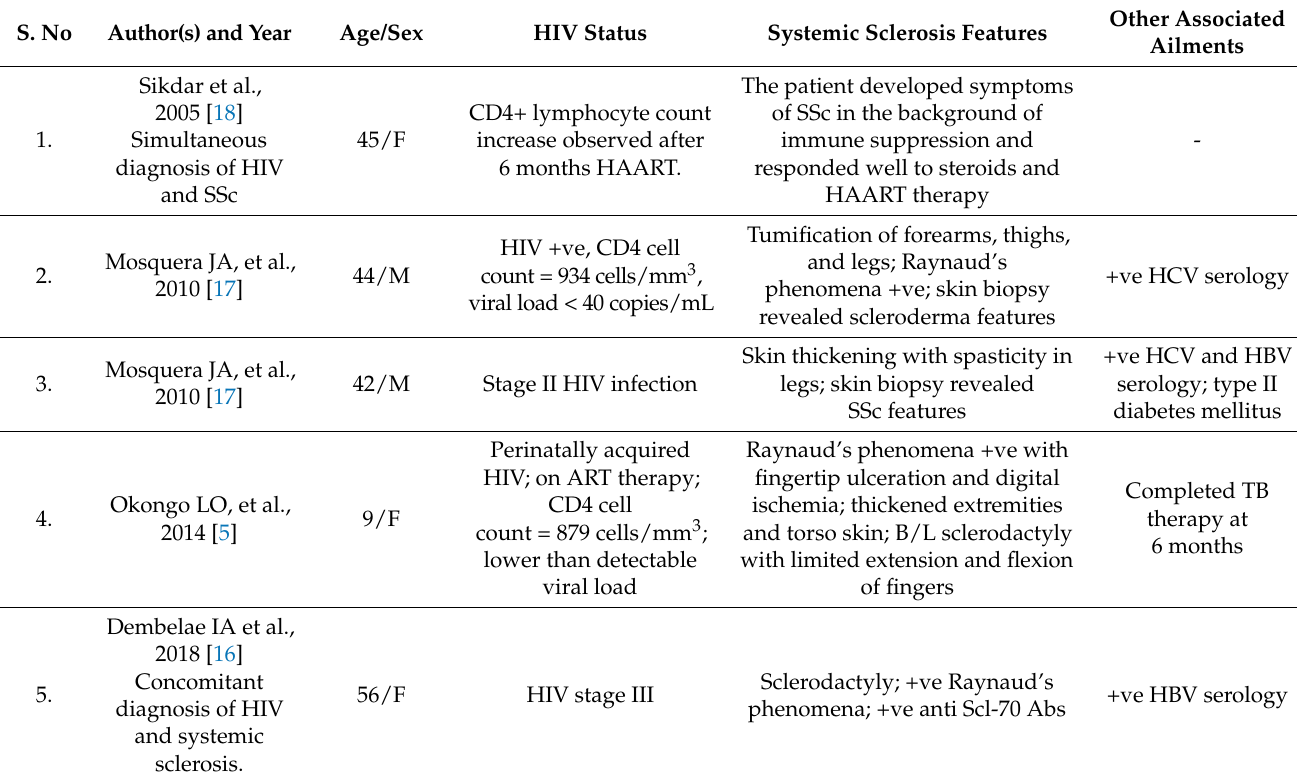
Table 2. Reported studies and cases of HIV infection and SSc.